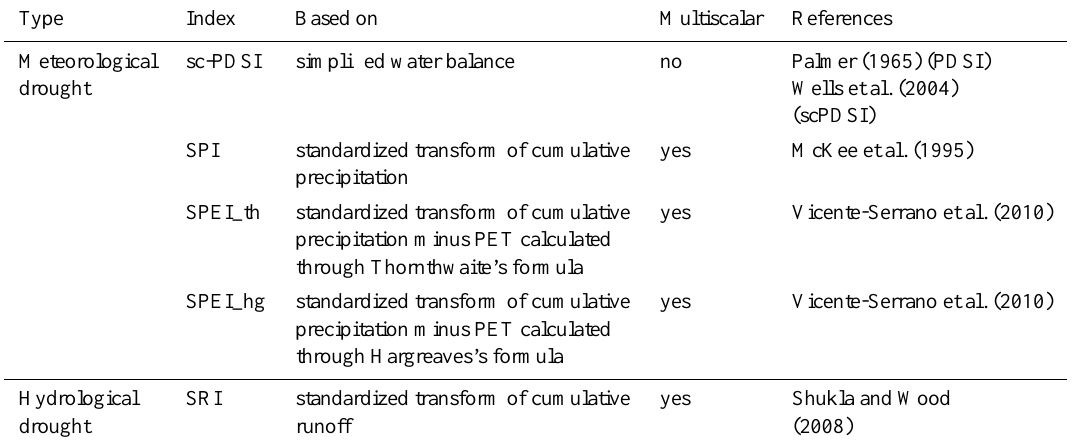
Table 2. Summary of the drought indices used in the present